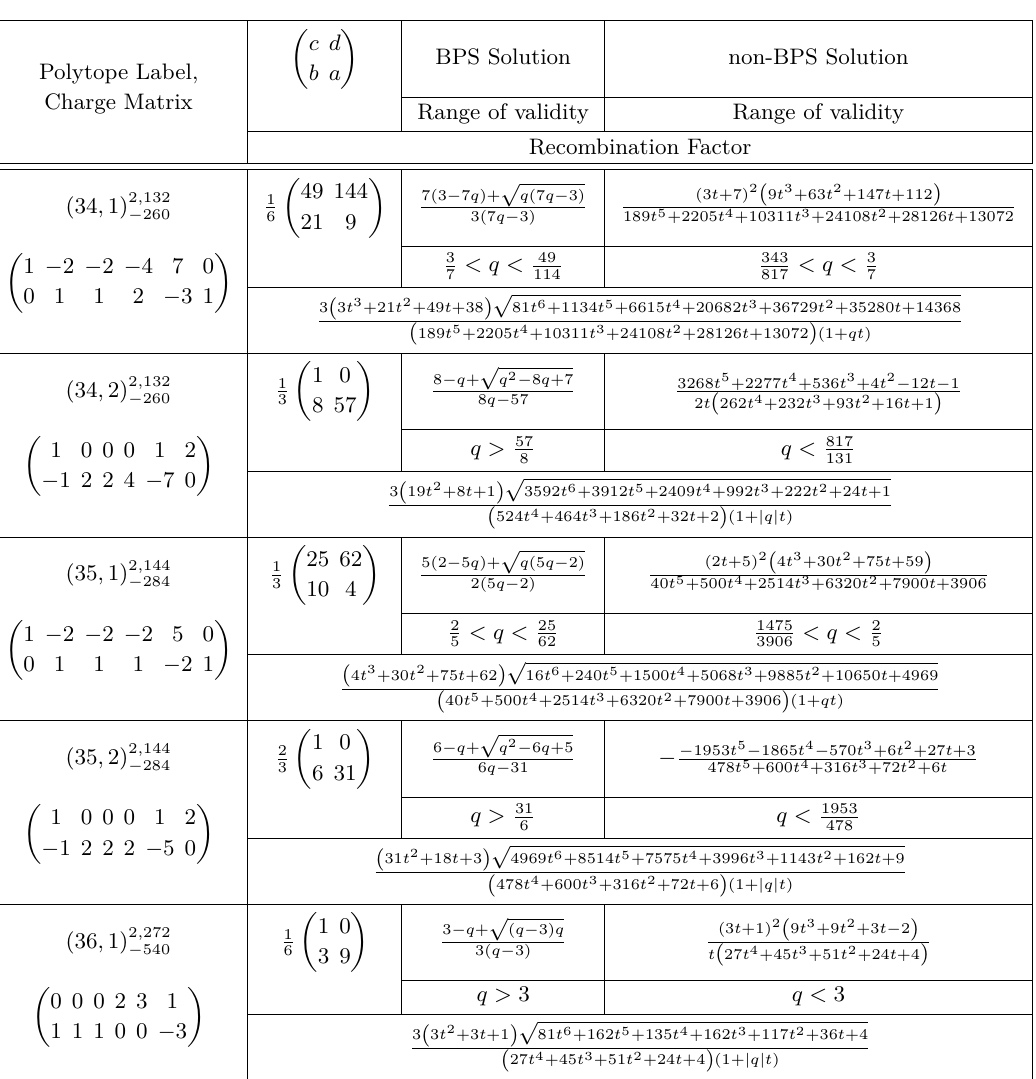
Table 8 . BPS and non-BPS extremal black holes in one-modulus THCY models,